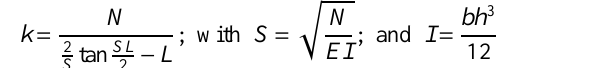
Figure 2. Force applied on the mobile block (c) (Fig. 1, right) as a function of its displacement 2 with and without stiffness compensation. 3